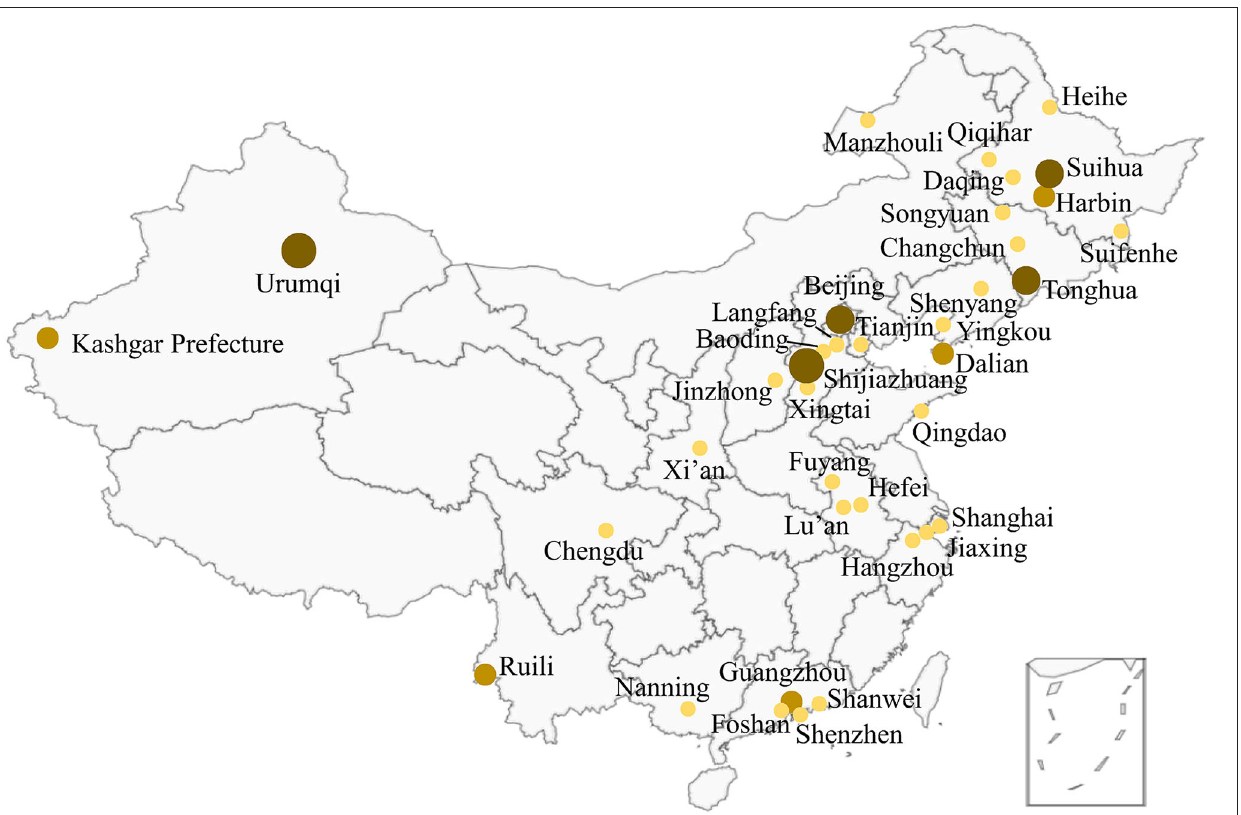
Asymptomatic patients (severe/moderate/mild) (all/symptomatic